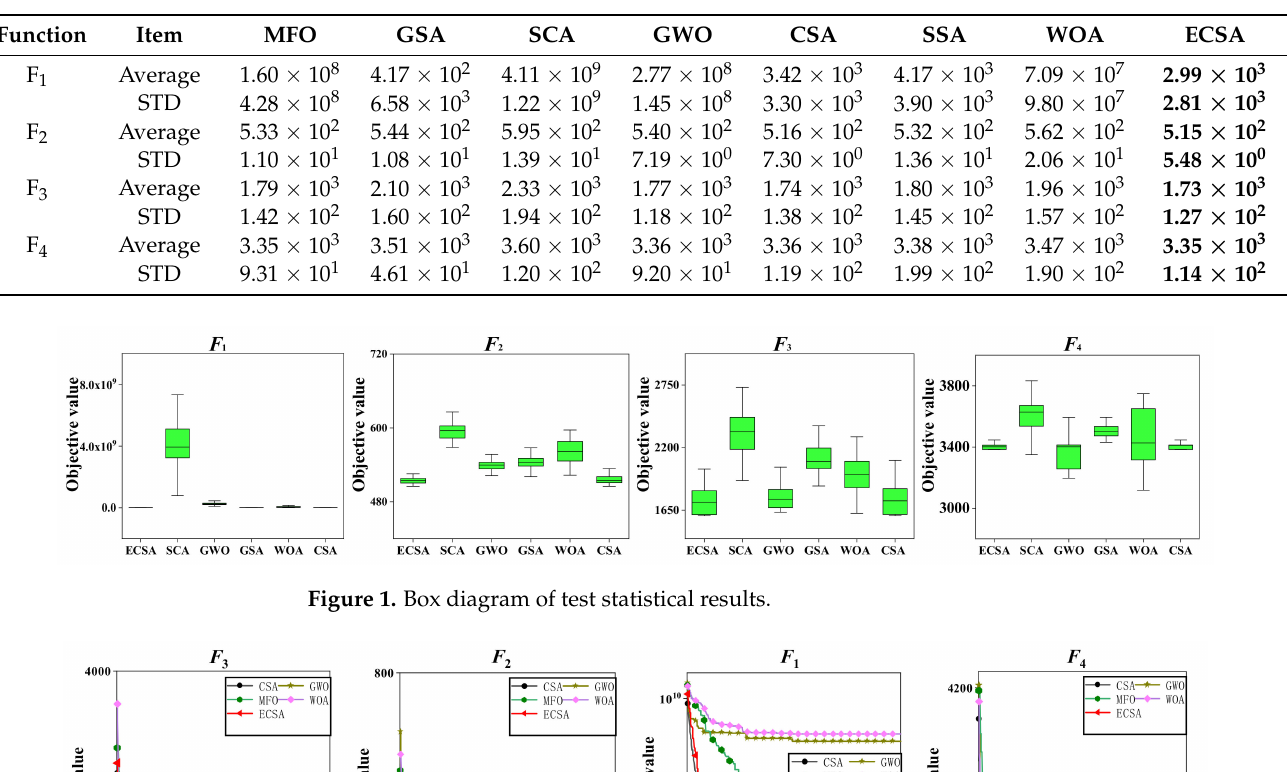
Table 3. Test function statistics results.